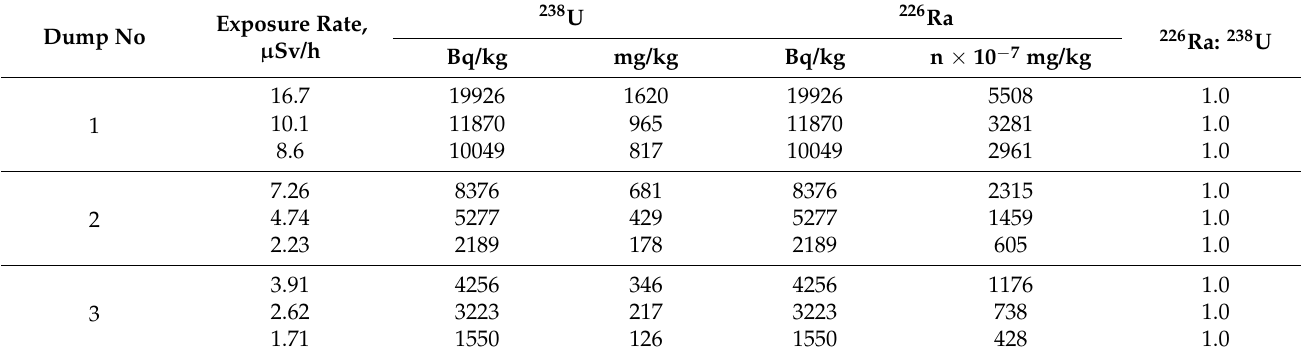
Table 1. Content of 238 U and 226 Ra in the gravel–stony portion of the dumps at the Kurung site. Exposure Rate, Dump No